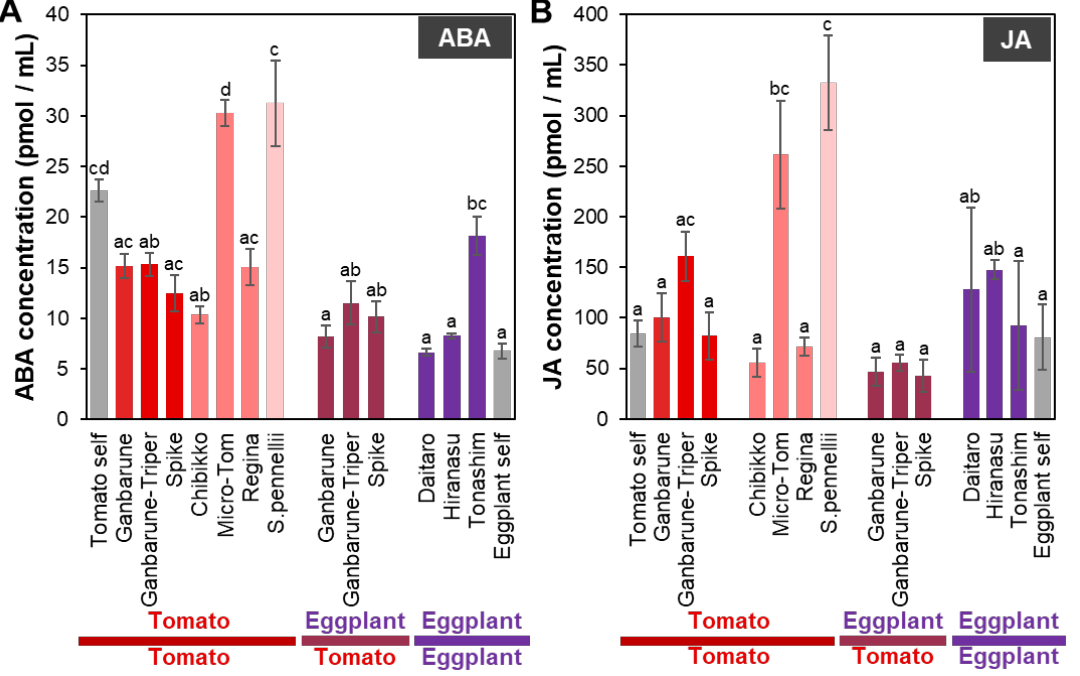
Figure 3. The concentrations of ABA and JA in the xylem exudates of various grafting combinations. The concentrations of ABA ( A ) and JA ( B ) in the xylem exudates of various grafting combinations. Gray, red, red–pink, pink, red–purple, and purple indicate self-grafted plants, tomato grafted onto various rootstocks of tomato cultivars, tomato grafted onto various dwarf tomato cultivars, tomato grafted onto wild tomato, eggplant grafted onto various tomato cultivars, and eggplants grafted onto various eggplant cultivars, respectively. Different letters indicate significant differences according to the Tukey-Kramer test ( p ≤ 0.05). Values are the means of four replicate samples, and error bars indicate the standard error of four replicate samples.